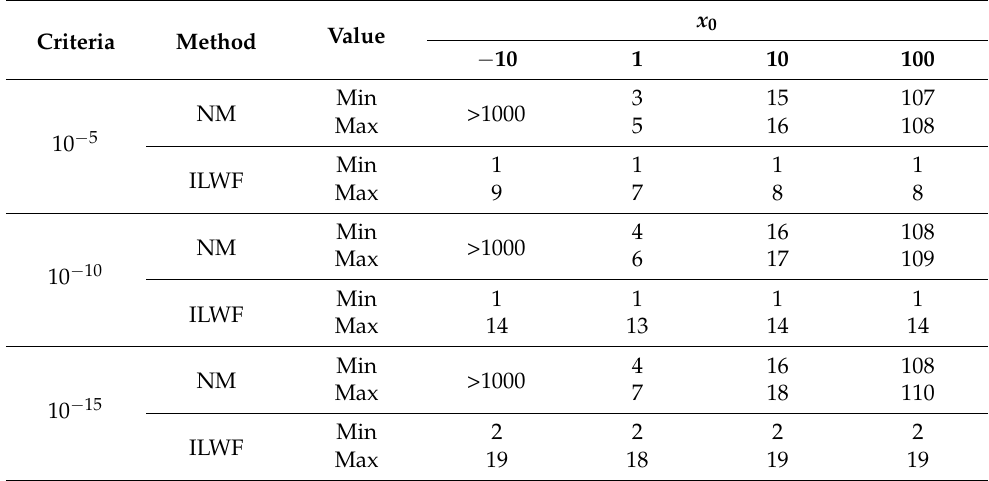
Figure 9. Required number of iterations for all voltage values with different stopping criteria using Table 5. Minimum and maximum number of iterations for NM and ILWF observing all measured points of RTC France solar cell.